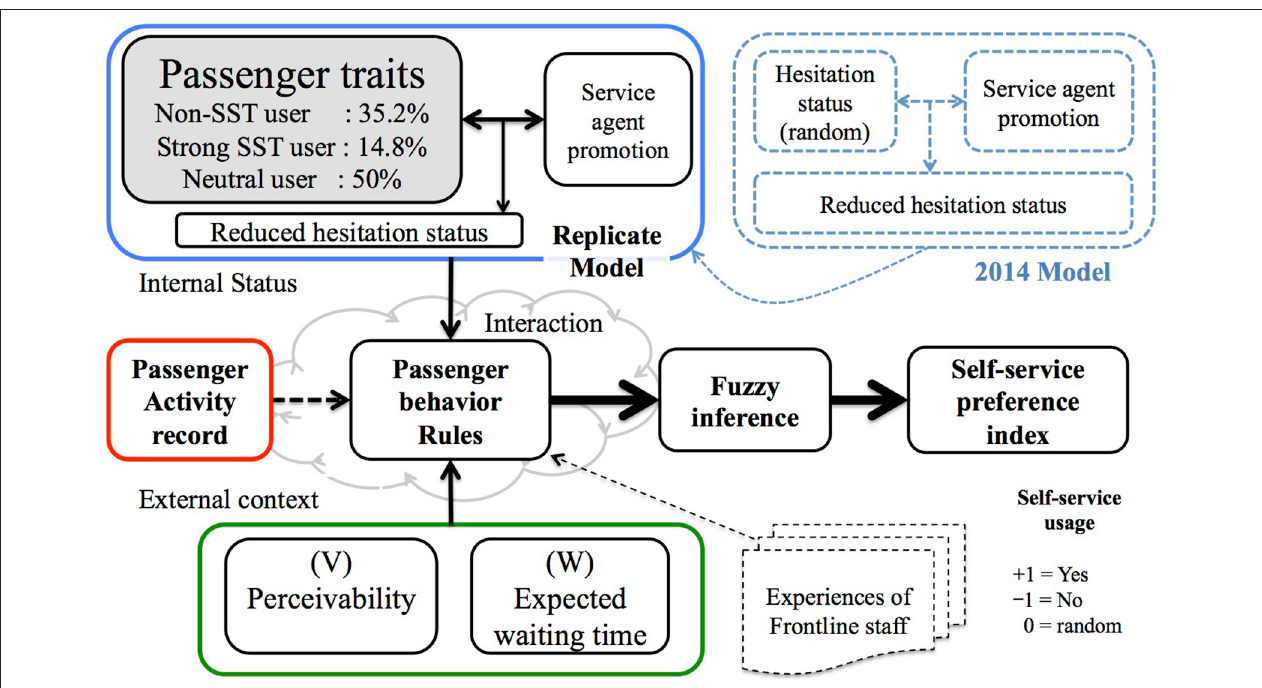
FIGURE 2 | Decision-making self-service adoption model at the airport (2017model).